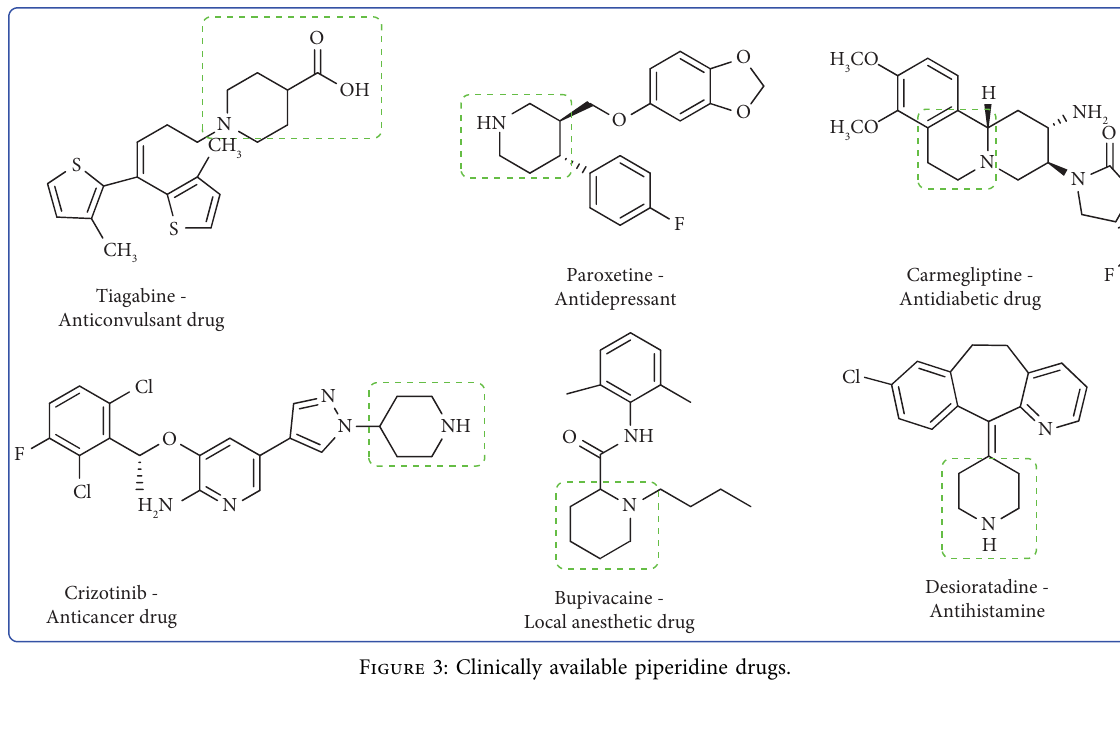
Figure 3: Clinically available piperidine drugs.